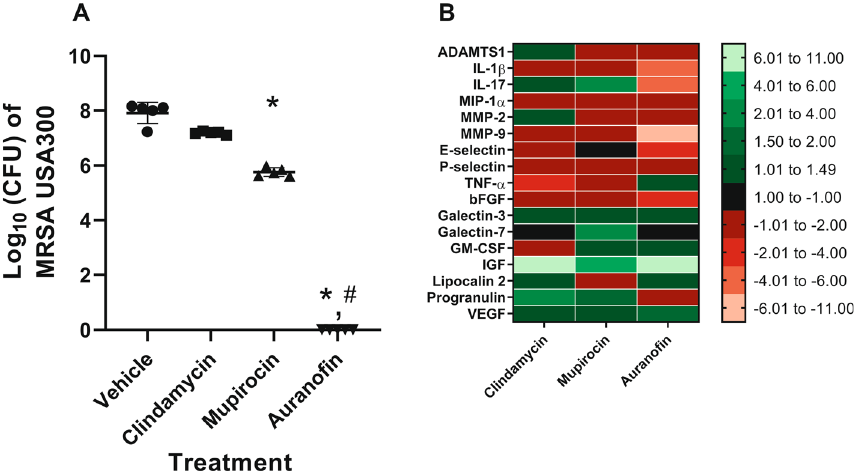
Figure 1. Bacterial burden and cytokines expression in pressure ulcers treated with auranofin and control antibiotics in diabetic mice. Male TALLYHO/JngJ mice (n = 5) were exposed to magnets to induce the formation of pressure ulcers that were subsequently infected with MRSA USA300. Infected pressure ulcers were treated with oral clindamycin (30 mg/kg, q.d.), topical mupirocin (2%), topical auranofin (2%), or vehicle alone (petroleum jelly) b.i.d. for four days. Twelve hours after the final dose, mice were euthanized, and the infected PUs were aseptically removed to determine bacterial burden and expression of cytokines related to inflammation and re-epithelization of wounded tissue. ( A ) MRSA USA300 colonies present in pressure ulcers after treatment with the vehicle alone, control antibiotics, or auranofin. Data are presented as log